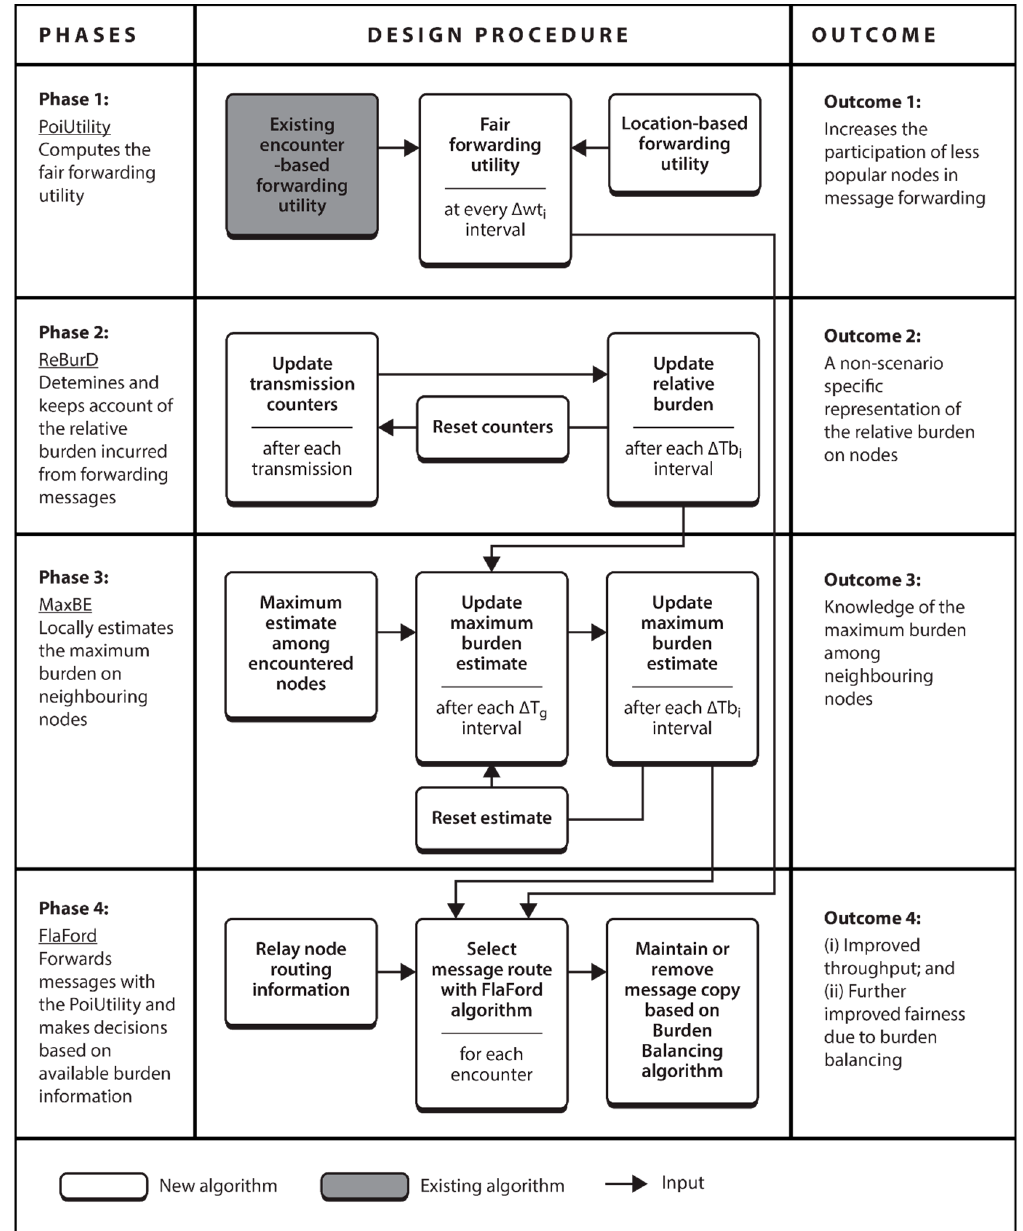
Figure 6. Functional block diagram of Fair Locality Aware Routing (FLARoute).